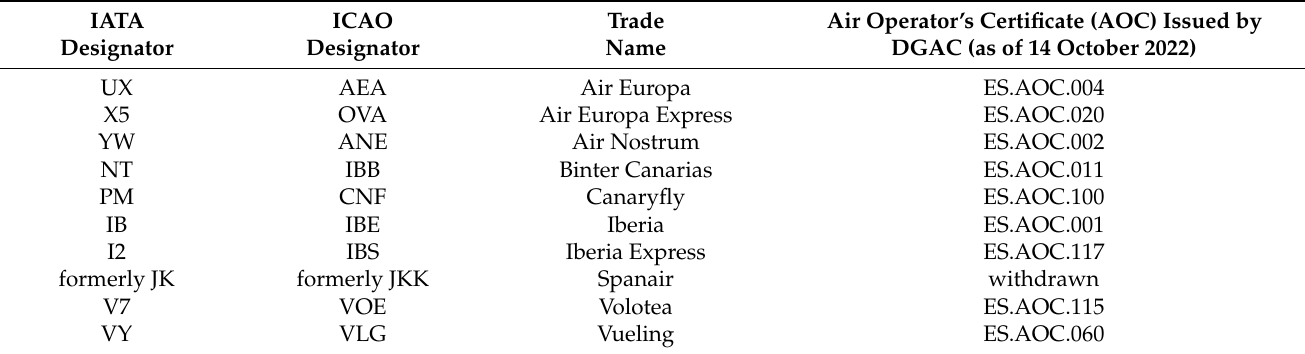
Table A2. List of Scheduled Airlines Considered in the Research.